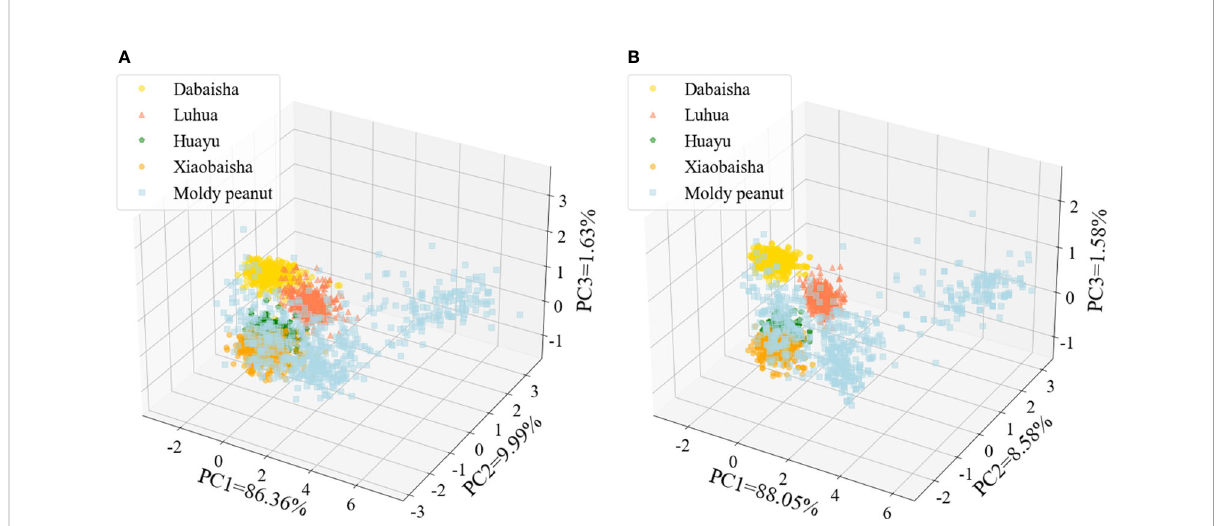
FIGURE 5 PCA visualization of hyperspectral data of peanut seeds. (A) RAW-PCA; (B)